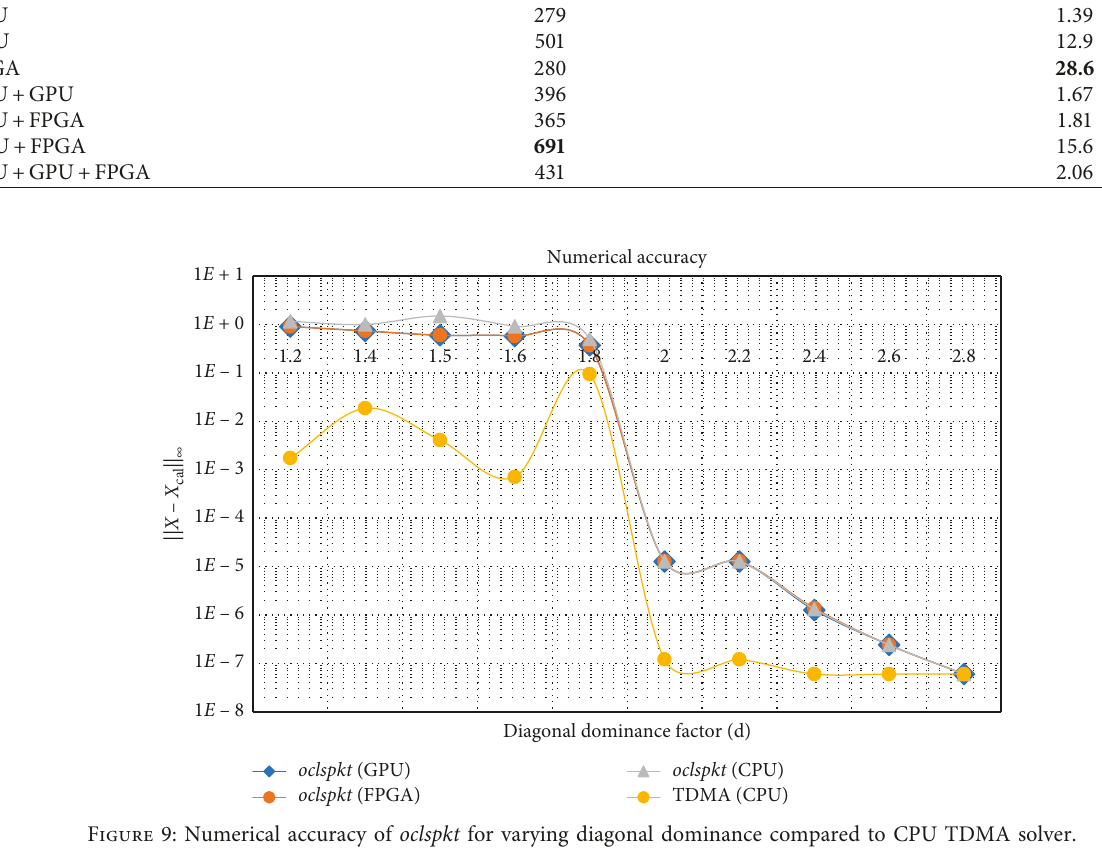
Table 5: Maximum observed average ( n � 16) compute performance and estimated energy efficiency of oclspkt for devices and hetero- geneous combinations. Device